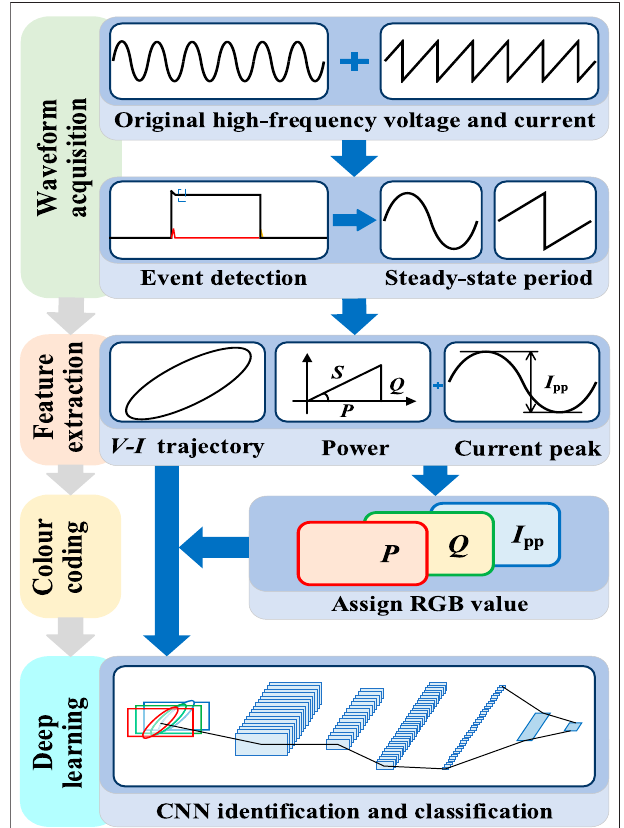
FIGURE 1 | Flow chart of the load identi fi cation